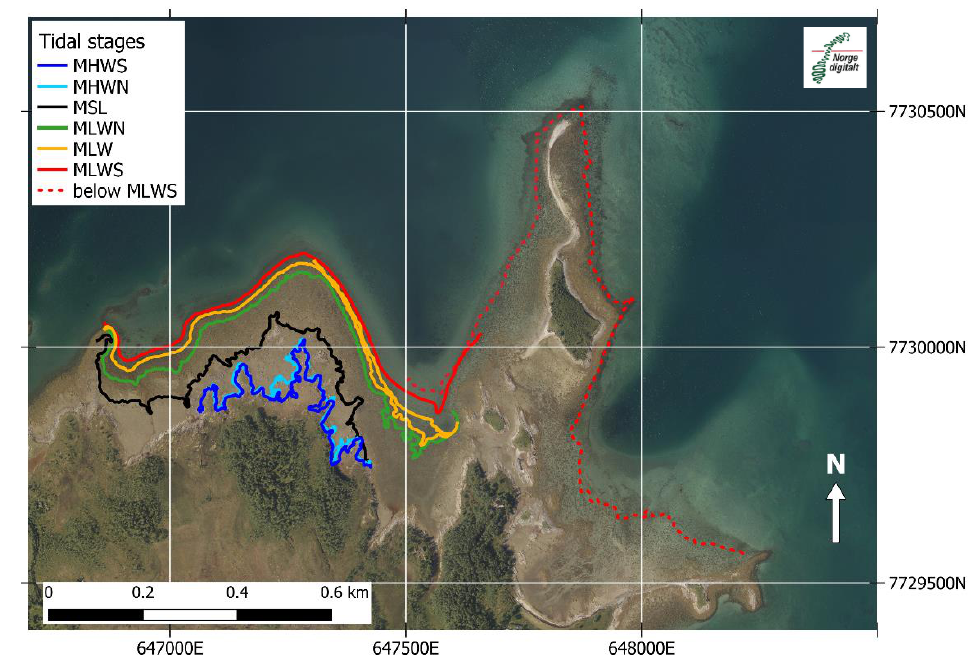
Figure 11. Aerial photograph at low tide from 2011 (© norgeibilder.com, Kartverket, Terratec AS) with the mapped tidal stages.